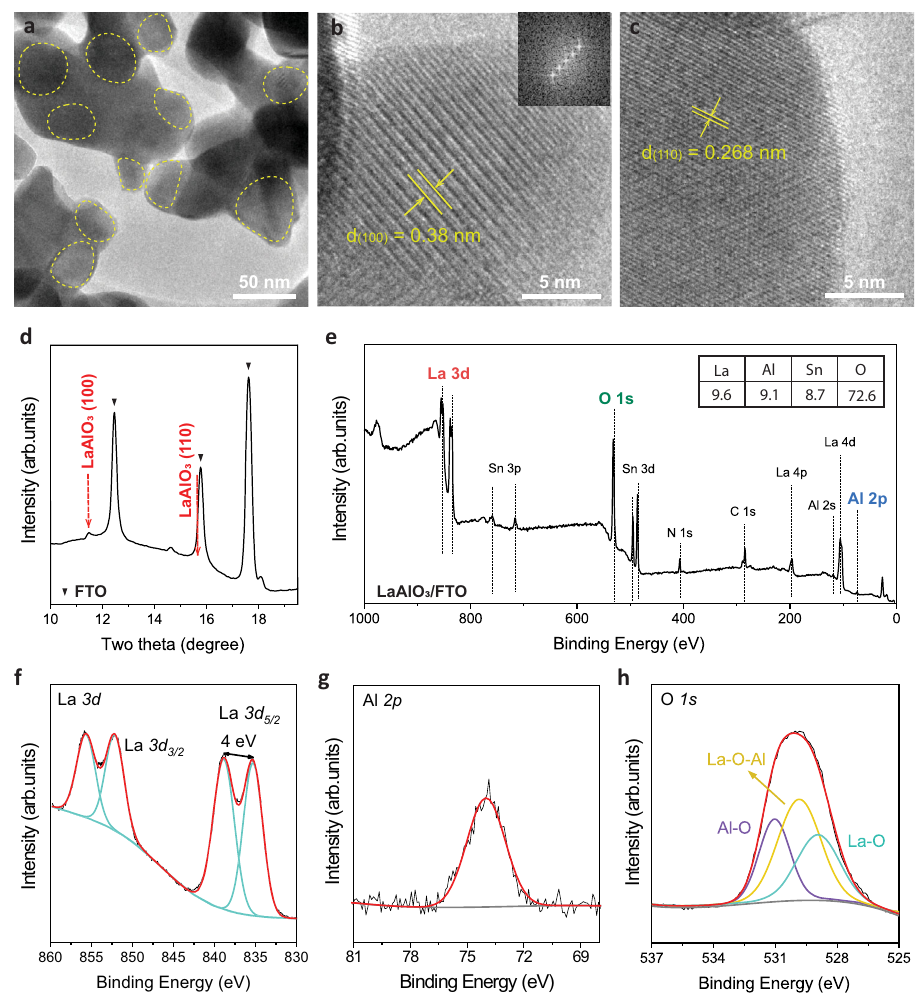
Fig. 4 | Key characterizations of the synthesized LaAlO 3 . a – c High-resolution TEM images of LaAlO 3 synthesized by sol-gel combustion method. From the TEM images, the morphology shows an irregular shape with the size of several tens of nm. And most of the parts look amorphous, while a crystalline LaAlO 3 phase was created at some surface parts. This resulted from the temperature spontaneously